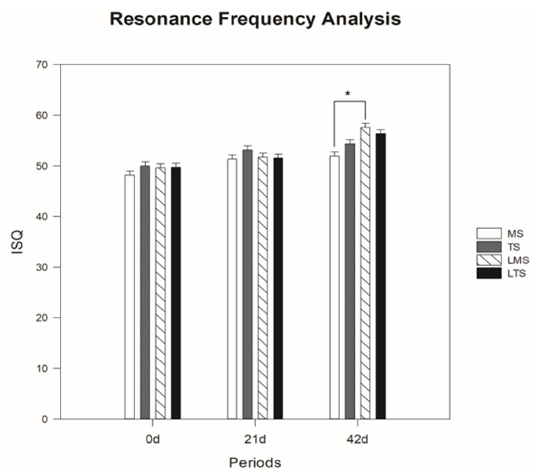
Figure 3. Mean values and standard deviation of the resonance frequency analysis between the groups in the periods of 0, 21 and 42 days (* p < 0.05).